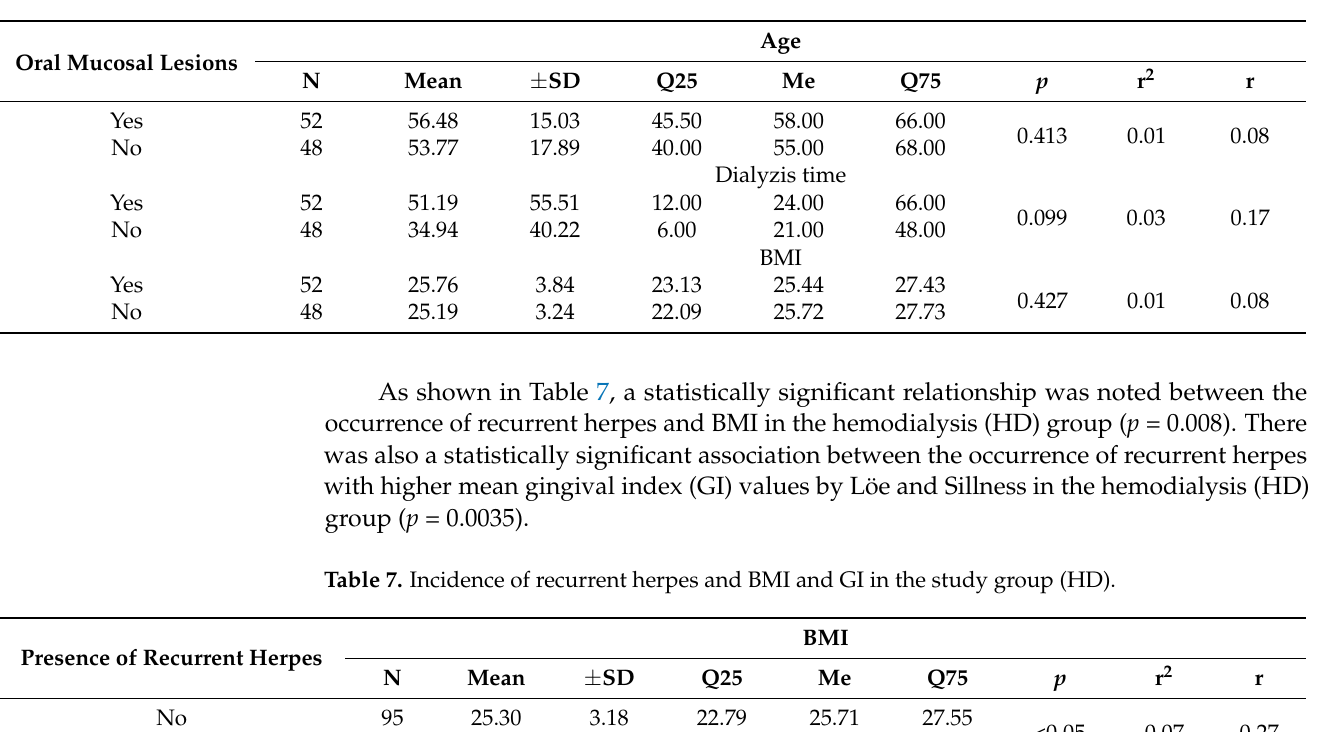
Table 6. Prevalence of oral mucosal lesions vs. age. dialysis duration and BMI values in the study group (HD).